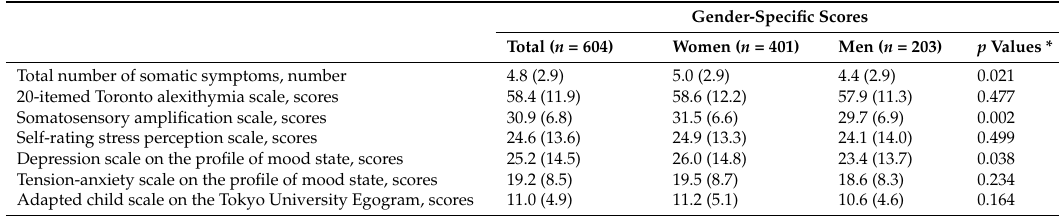
Table 1. Clinical data from 604 outpatients defined as having “psychosomatic illness” in a Japanese psychosomatic clinic.